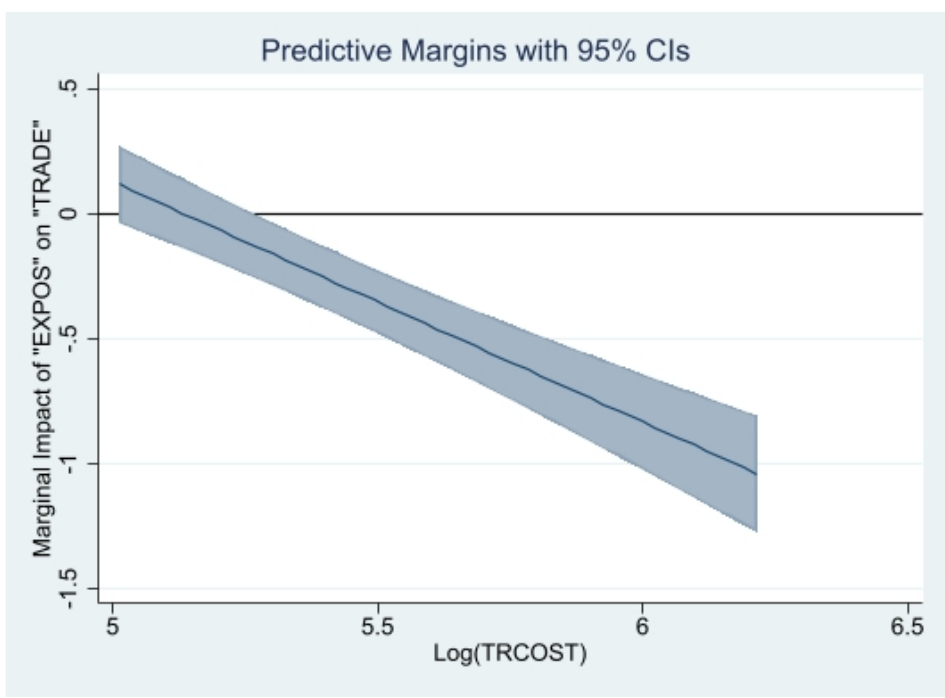
Figure 10. Marginal impact of “EXPOS” on “TRADE” for varying levels of trade costs. Source: Author.